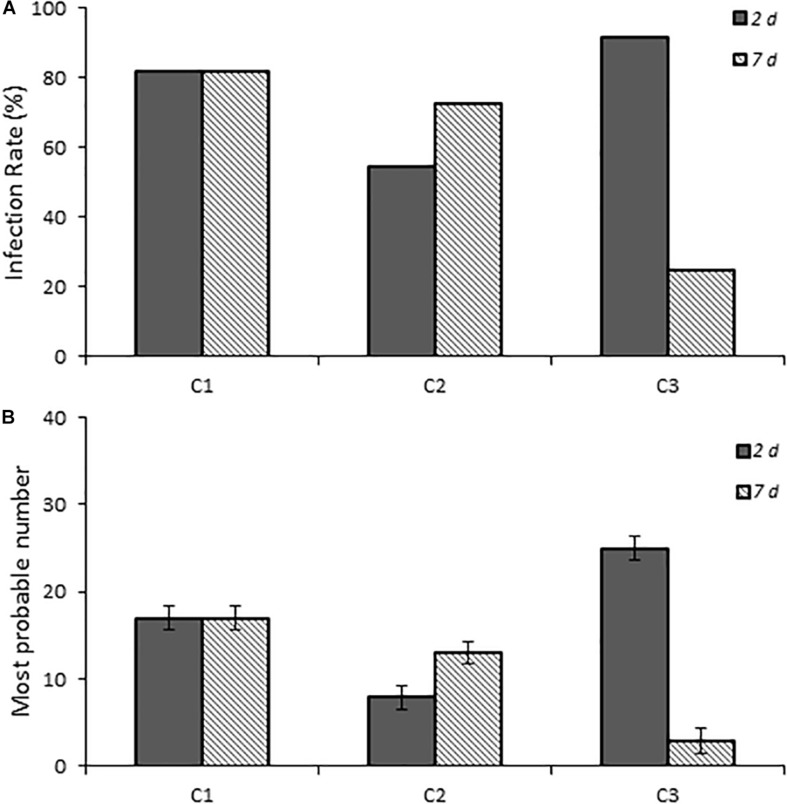
Infection rates and fecal burden levels of Campylobacter from chicks infected with clinical isolates of Campylobacter spp. (A) shows chicks infected with dose B Campylobacter spp. Percent infected was determined by dividing the number of infected chicks by the total number of chicks inoculated with the various Campylobacter species. Chicks were considered infected if fecal samples collected at the various times were positive for Campylobacter spp. as determined by using the passive-filter plating as described in the section “Materials and Methods.” (B) shows the fecal burden as measured by using the most probable number calculator.